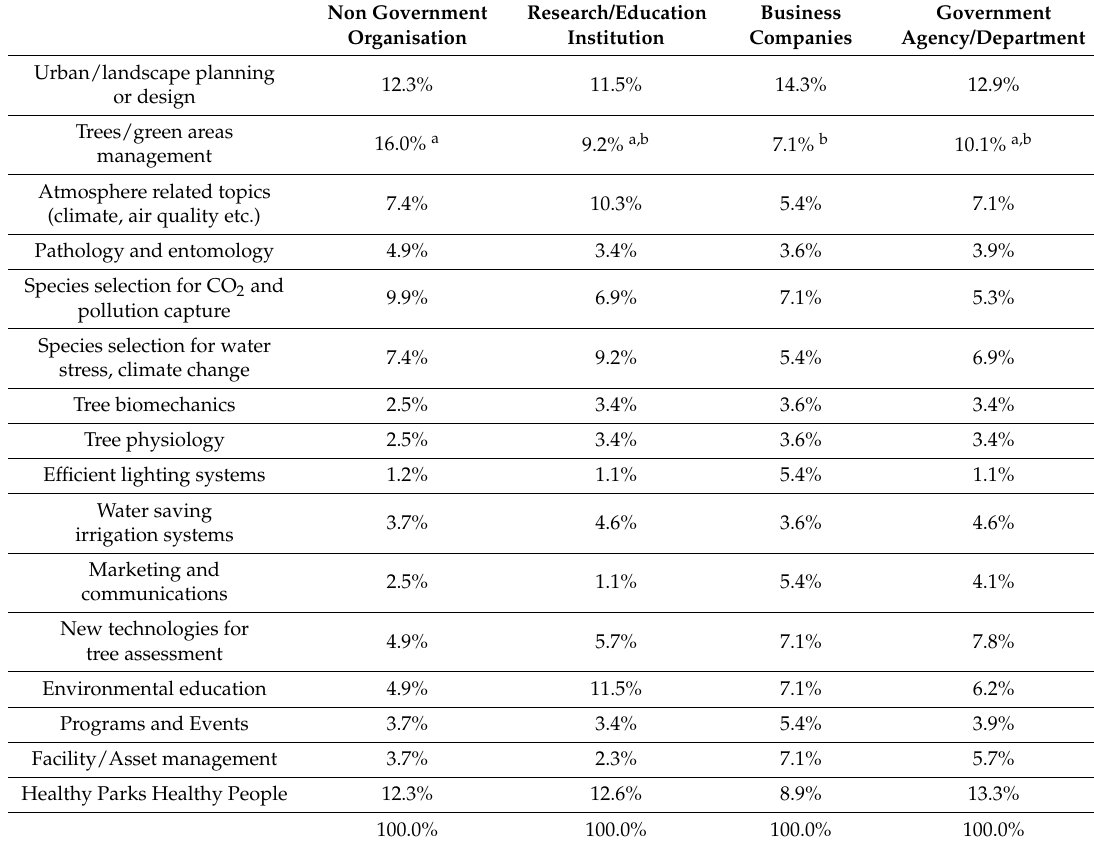
Table 2. Subjects that deserve more attention in training